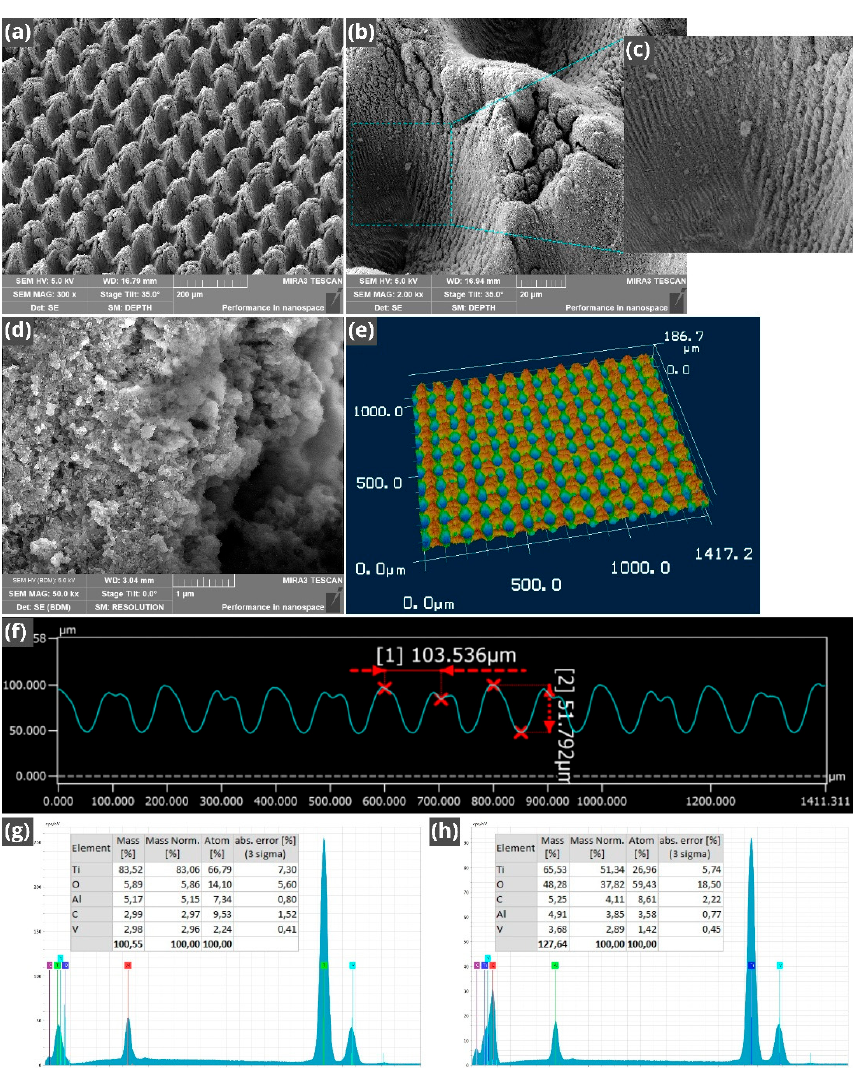
Figure 2. ( a ) Scanning electron microscope (SEM) image of the array of micropillars/microholes pro- duced by femtosecond laser. ( b ) SEM image of a LIPSS-structured micropillar/microhole. ( c ) Mag- nified SEM image of LIPSS produced on micropillar/microhole walls. ( d ) SEM image of nanostruc- tural features on the micropillar top. ( e ) Three-dimensional (3D) optical image of the array of mi- cropillars/microholes. ( f ) Profile of the micropillars. ( g ) Elemental composition of the sample surface before laser processing. ( h ) Elemental composition of the sample surface after laser processing.